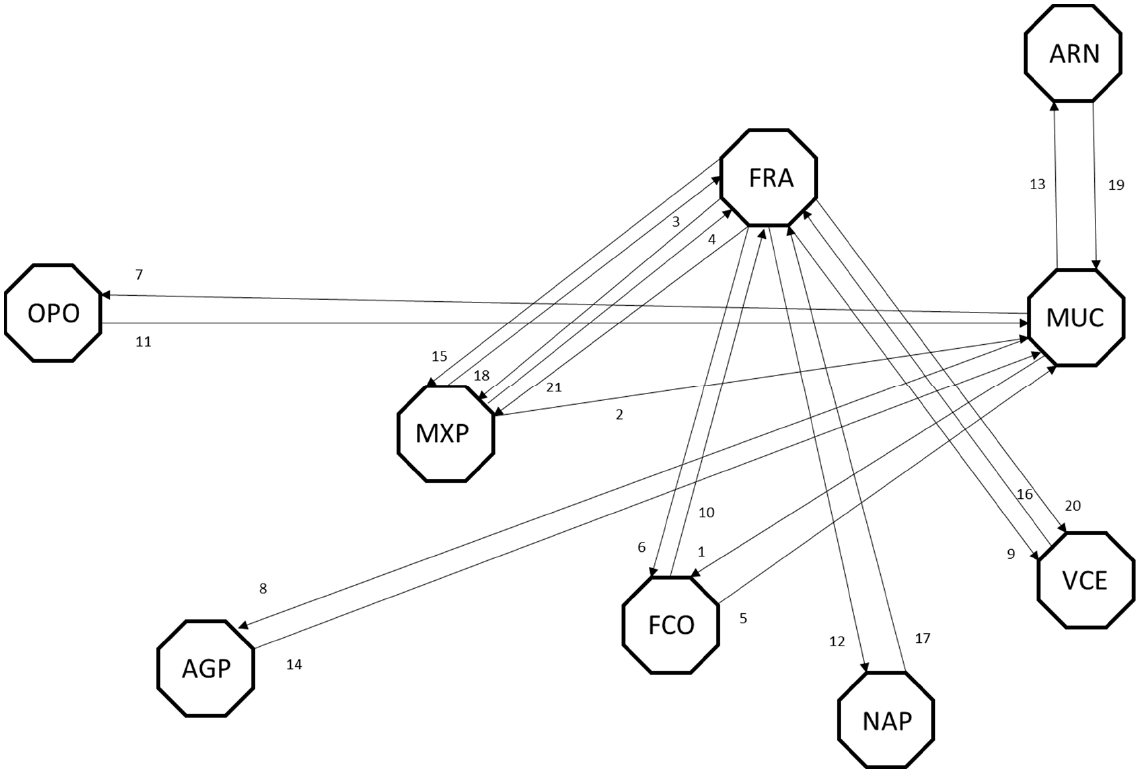
Figure 1. Diagram of all planned flights during the day.